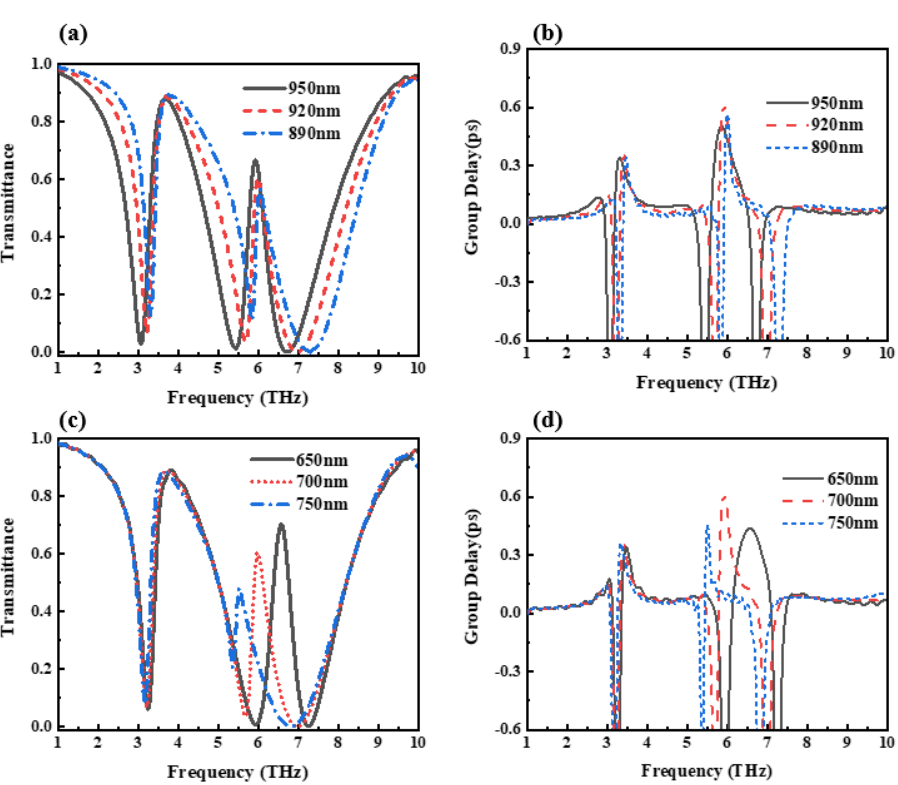
Figure 11. The effect of the upper and lower graphene width variation on the EIT effect. ( a ) The structure transmission spectrum. ( b ) Group delay change when the width of the upper graphene layer changes. ( c ) The structure transmission spectrum. ( d ) Group delay change when the width of the lower layer graphene changes.